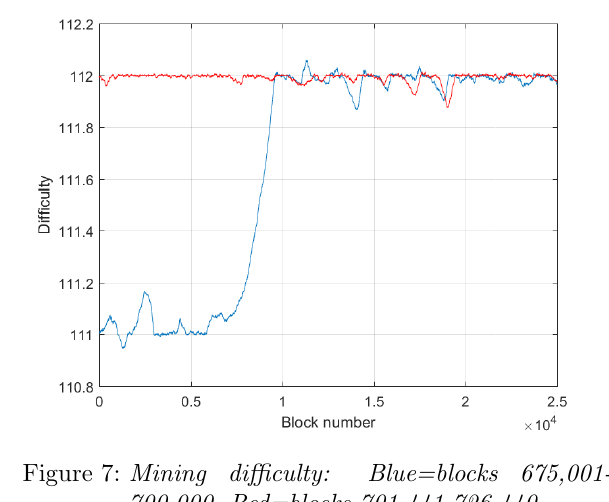
Figure 7: Mining difficulty: Blue=blocks 675,001- 700,000, Red=blocks 701,441-726,440.